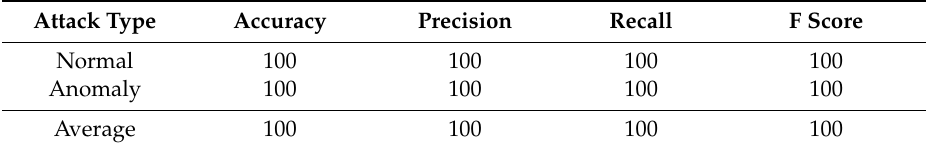
Table 6. Precision, Recall, and F Score.